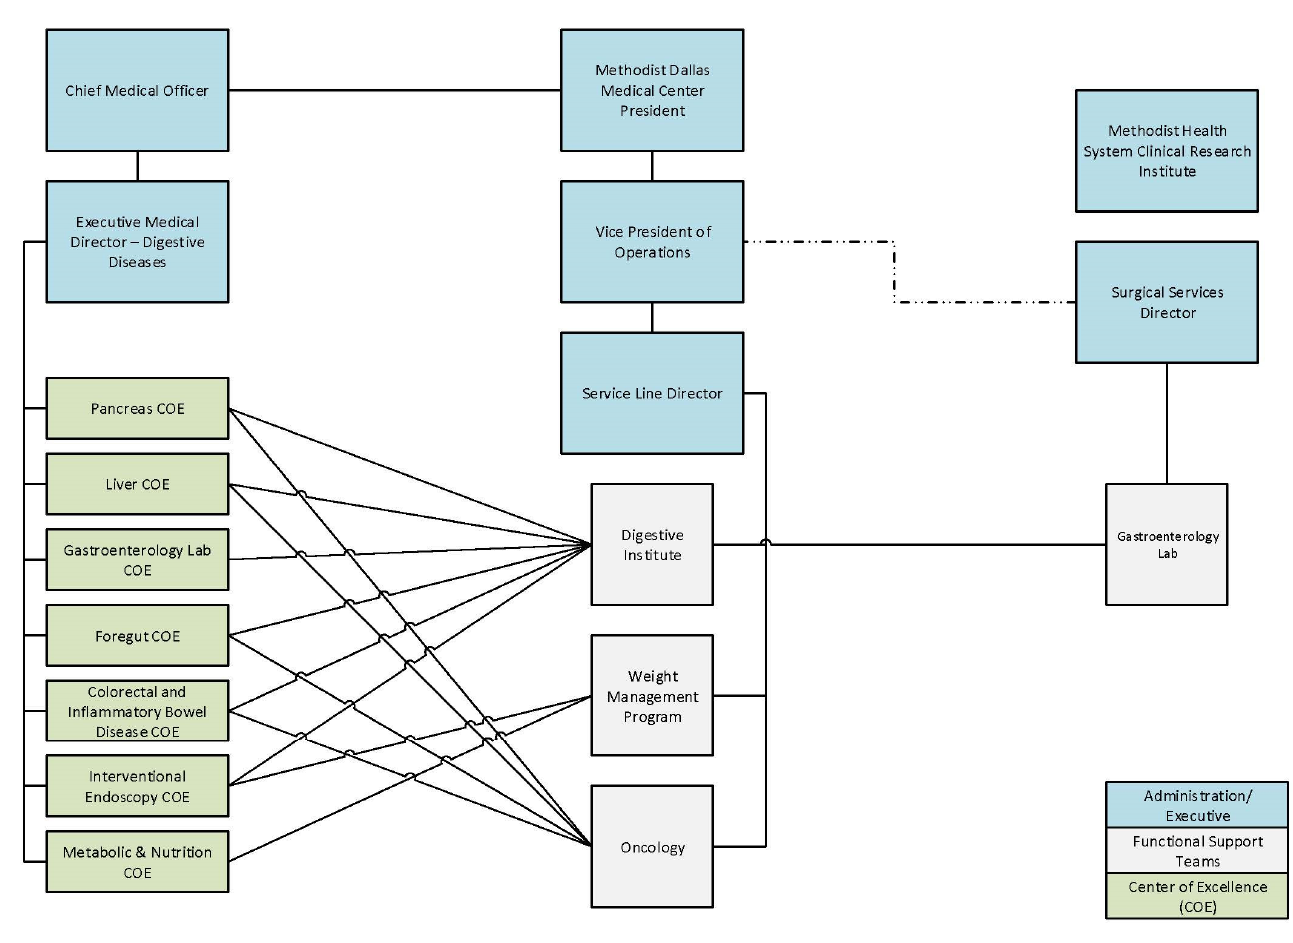
Figure 1. Matrix leadership structure.